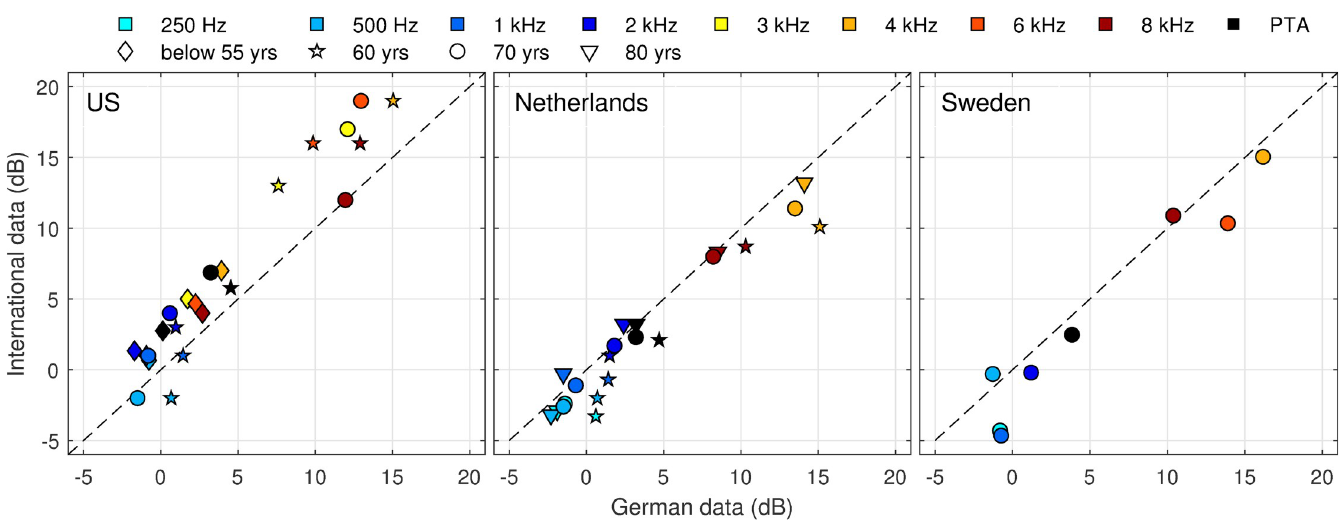
Fig 3. HTL gender gap observed in four population-based studies. HTL differences were calculated subtracting mean/median HTL derived in females and males by frequency and age group (male minus female). Note: The analysis of the German data was aligned separately to the methods used in each study. Comparison was performed for the better ear on a frequency-by-frequency basis (US) reported in [4,26],mean right and left ear HTL averaged over two 5-years bands (NL) reported in [10], and interpolated/grouped median (SE) reported in